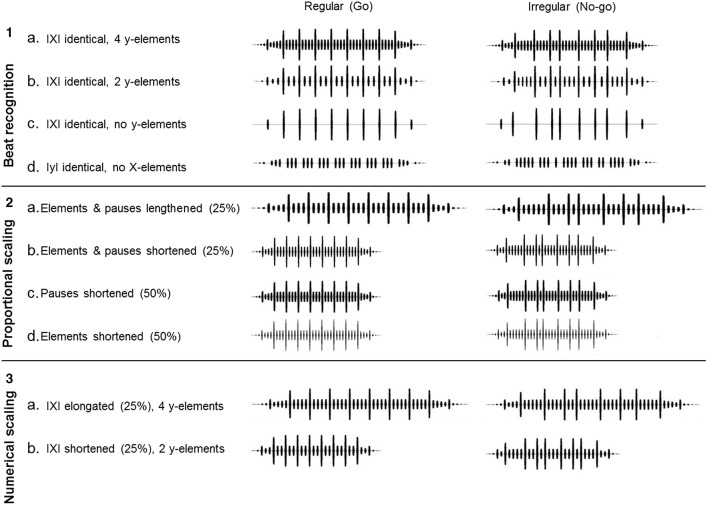
Visualizations of the different test pairs with the regular and the irregular string variants, grouped in three test sets. The longer vertical lines indicate the X-elements, shorter lines indicate the y-elements.